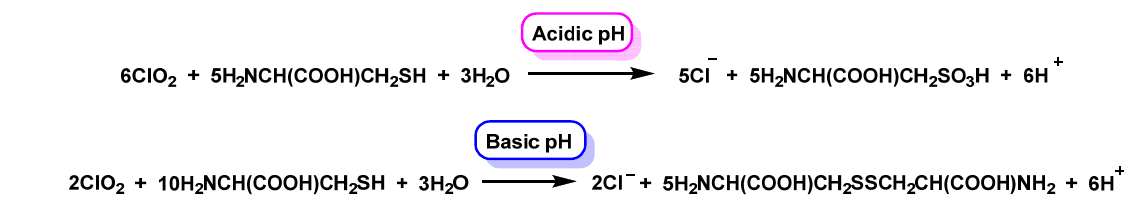
Figure 37. Proposed mechanism for the reactions between ClO 2 and cysteine.